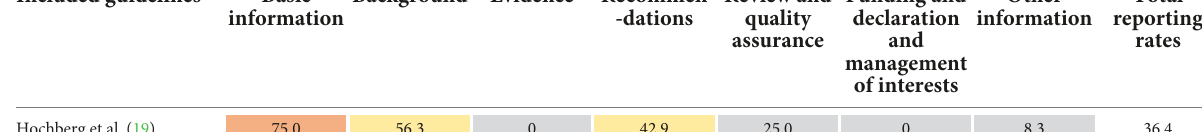
TABLE 3 Reporting rates (%) and ICC score of included guidelines and